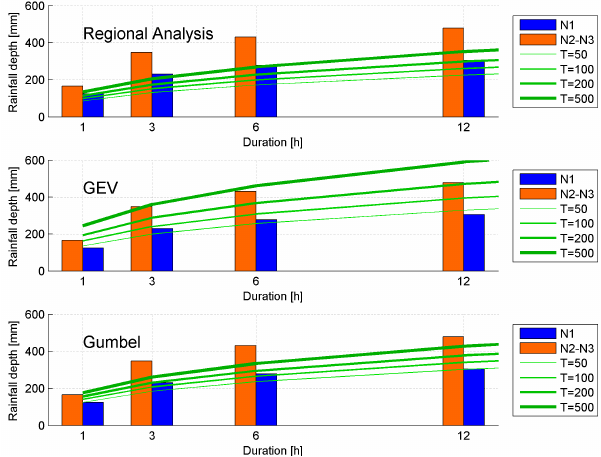
Fig. 8. Depth-duration-frequency curves obtained through the three Figure 8. Depth-duration-frequency curves obtained through the three applied 2 applied approaches (GEV and Gumbel site analysis and Regional approaches (GEV and Gumbel site analysis and Regional Analysis). N1 stands for N1-3 Analysis). N1 stands for N1-Gavette, N2-N3 stands for N2-N3- Gavette, N2-N3 stands for N2-N3-Fereggiano 4